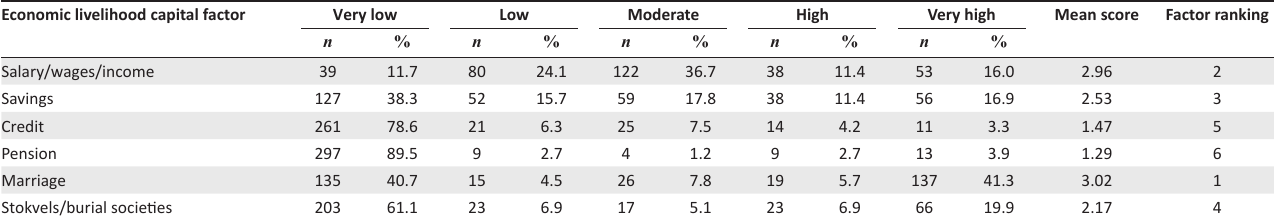
TABLE 5: Ratings of the economic livelihood capital factors ( n = 332). Economic livelihood capital factor V ery low Low